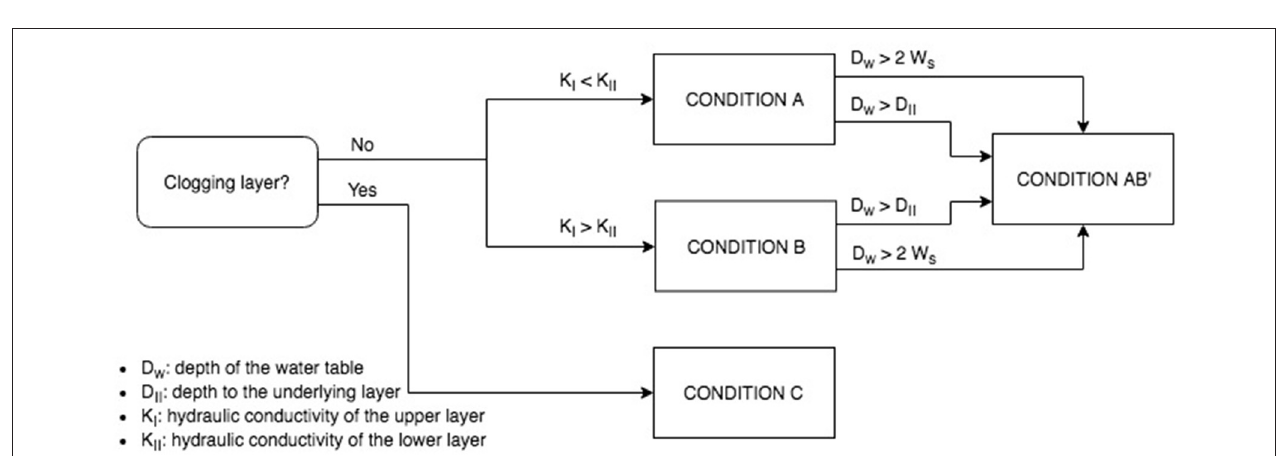
FIGURE 4 | Flow-chart to identify Bouwer’s conditions of